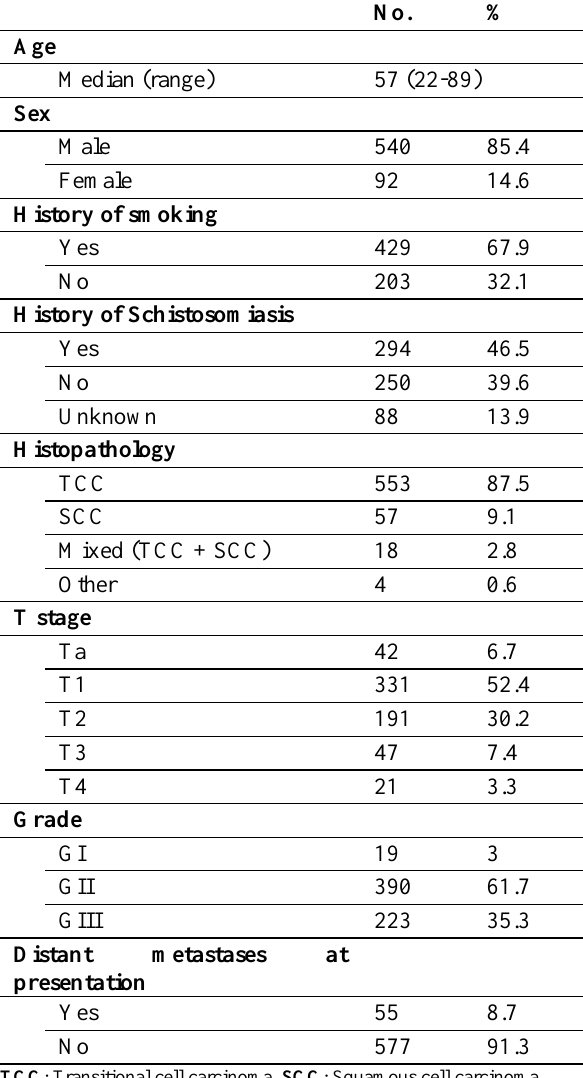
Table 1: Clinical and pathological characteristics of our